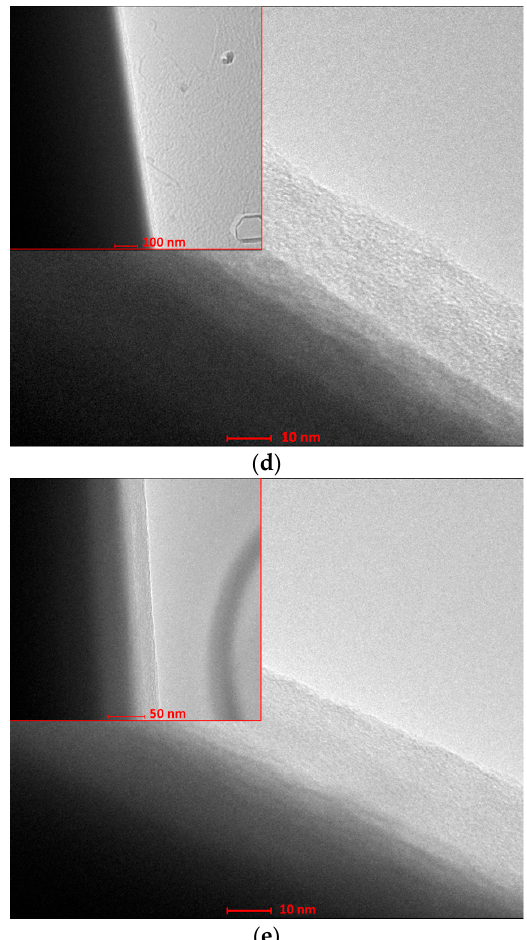
Figure 5. TEM images of uncoated carbon fibers ( a ) and carbon fibers modified with coating 1 ( b ) coating 2 ( c ); coating 3 ( d ); and coating 4 ( e ).